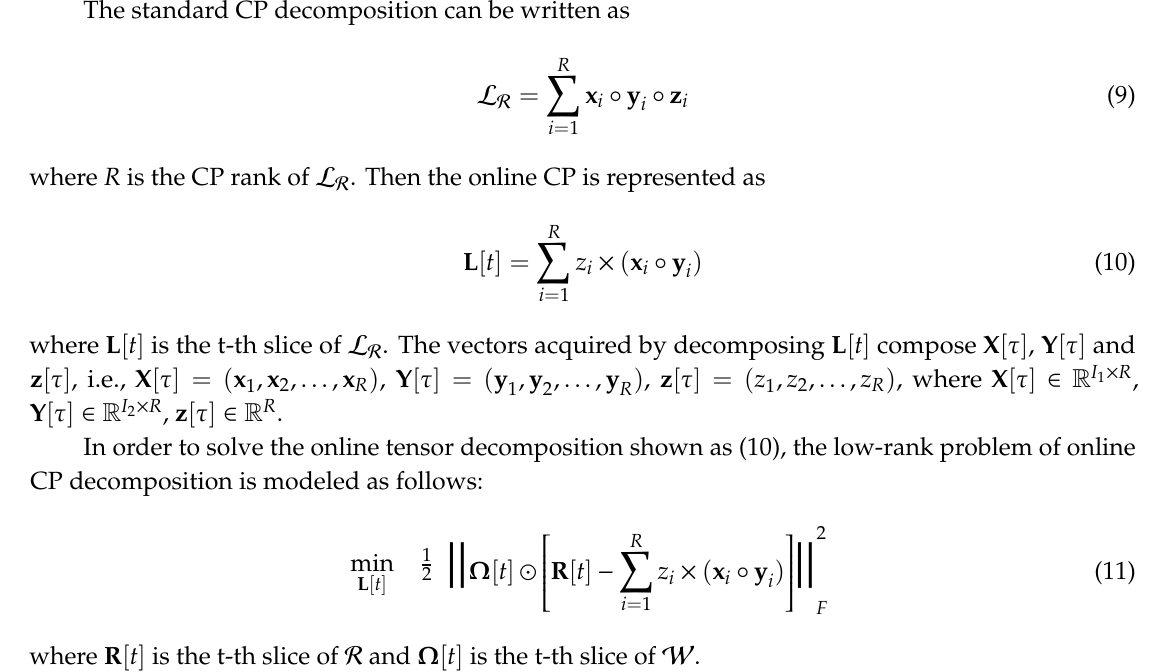
Figure 6. Flow chart of Online CANDECAMP / PARAFAC decomposition - multi-pass SAR interferometry (OLCP-InSAR) for tensor model (Algorithm 1).